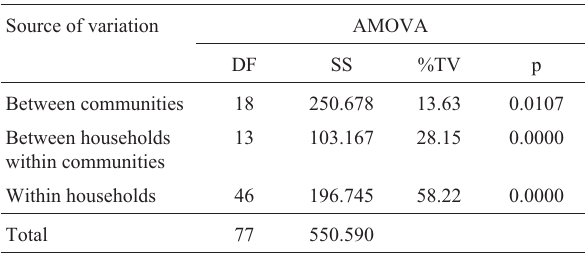
Table 3 - Analysis of molecular variance (AMOVA) of the microsatellite data for 78 sweet potato ( Ipomoea batatas ) accessions (landraces and clones) from the Vale do Ribeira, São Paulo, Brazil. The table shows de- grees of freedom (DF), sum of squares (SS), percentage of total variation (%TV) and the probability (p) value for 1023